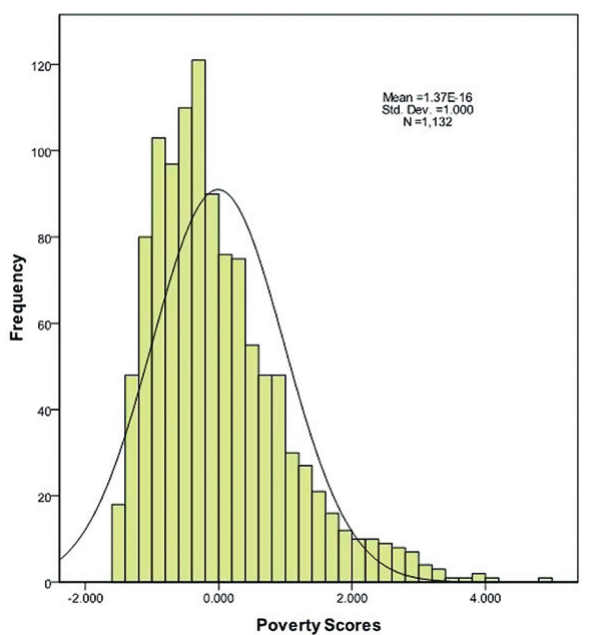
Fig. 2. Histogram showing poverty scores of respondents’ households Source : Survey